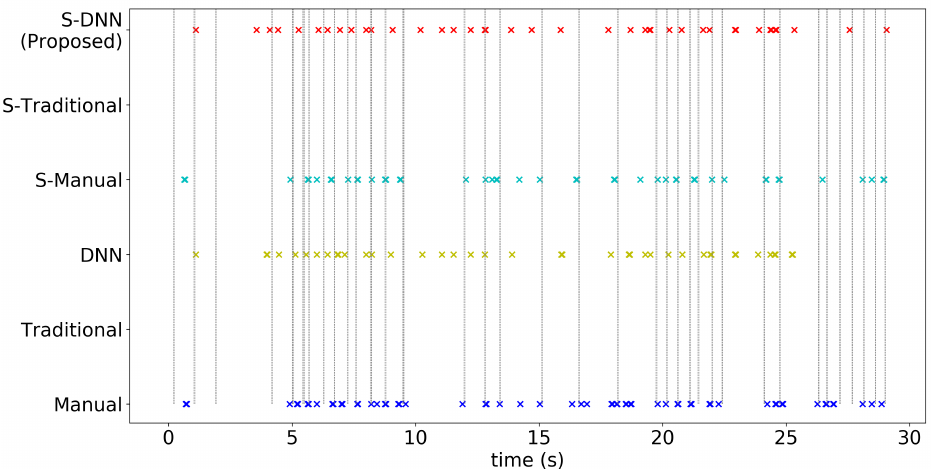
Figure A11. Prediction consistency of event counting compared with ground truths for capillary